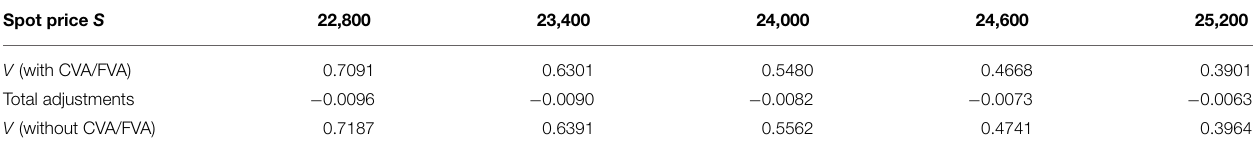
TABLE 7 | Prices of digital put under KoBoL process as of 9 January 2015, time to maturity T = 0 . 463 , spot, strike S = K = 24 , 000 , risk-free rate r = 0 . 52 % , collateral rate r